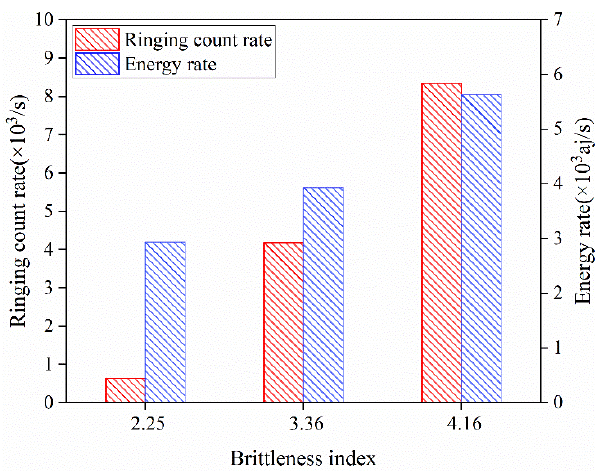
Figure 9. Relationship between AE released at the failure of the specimen and brittleness index.